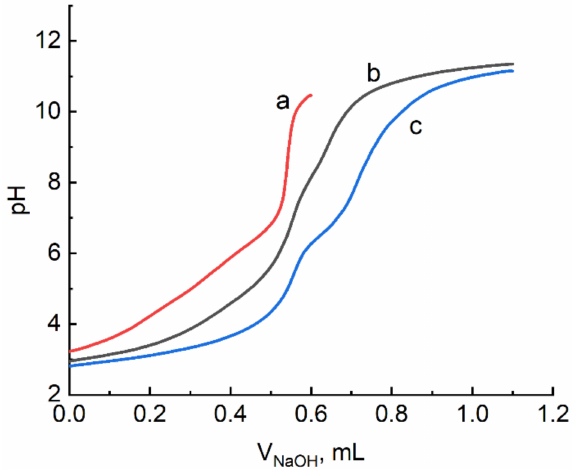
Figure 2. Titration curves of citric acid solution in ( a ) water and ( b , c ) in the presence of gadolinium ions. C H4L 1.0 mM, C NaOH 0.312 M, C Gd(III) ( b ) 0.5 mM, ( c ) 1.0